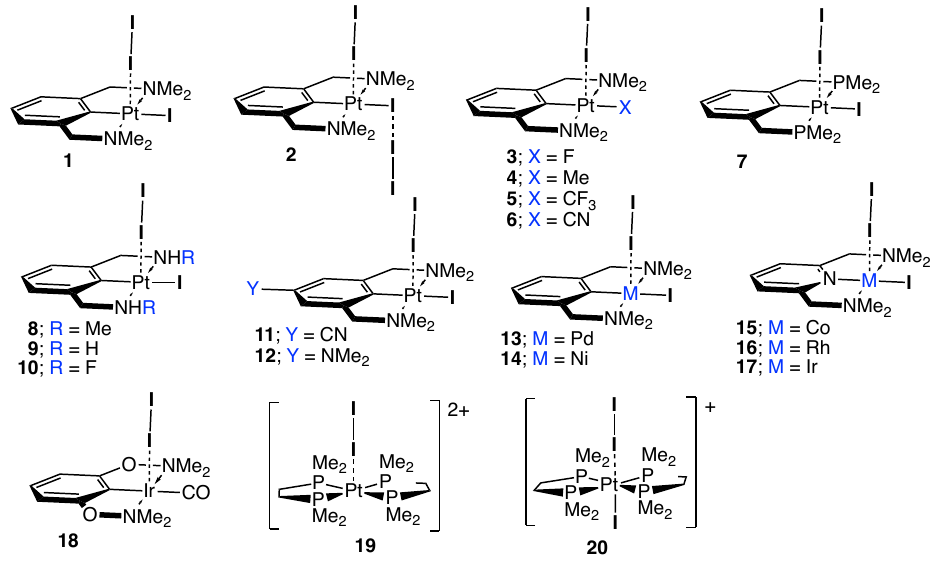
Figure 1. Sketches of complexes 1 – 20 investigated in this